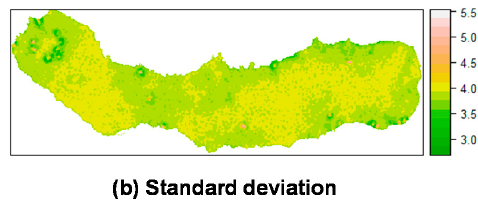
Figure 4. Summary of the spatial random effect (Gaussian random field) for the best mixed effects models and their reduction for M. faya in São Miguel Island. Mean ( a ); Standard deviation ( b ). PR: Practical range.